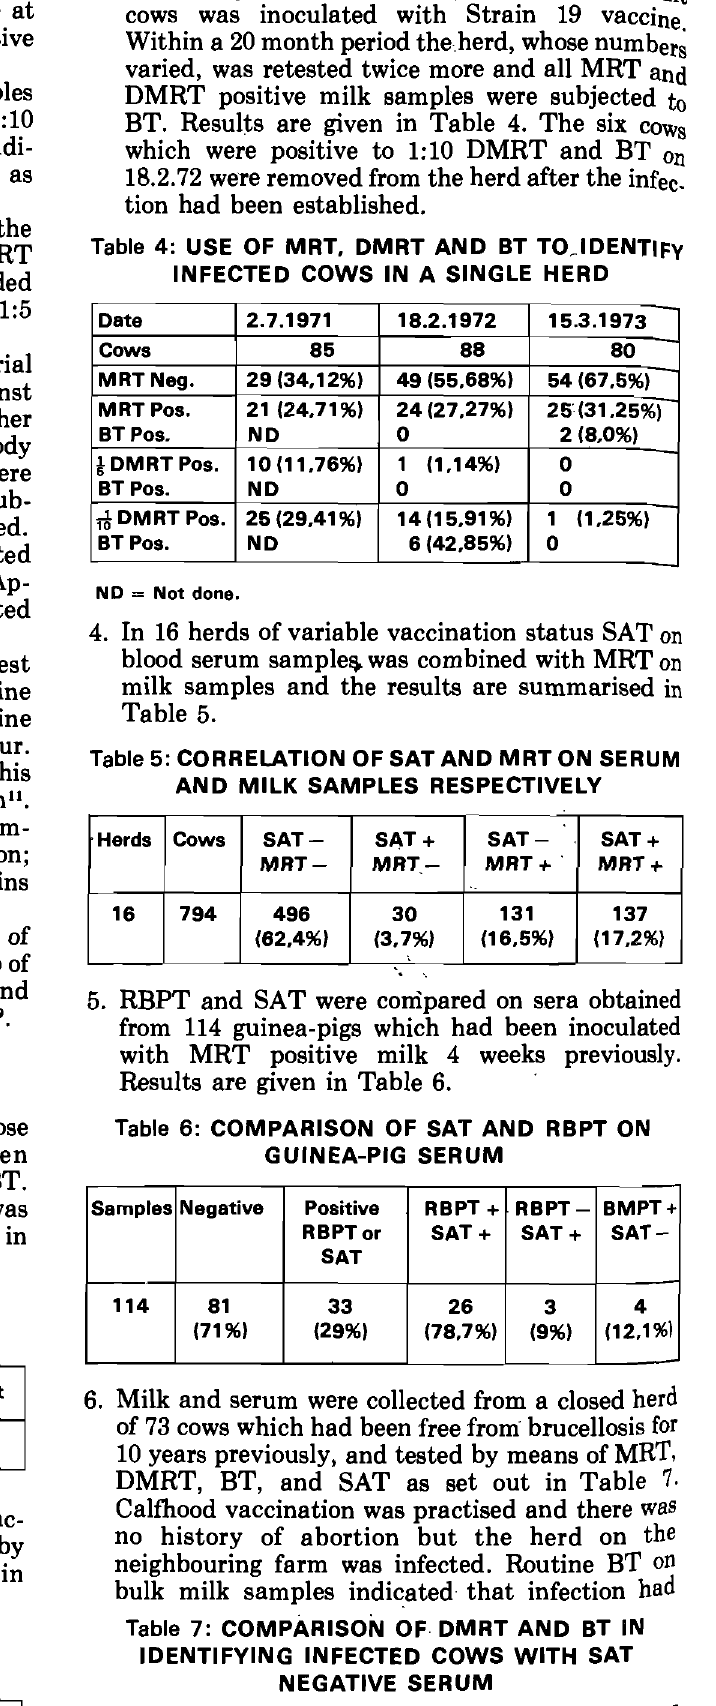
Table 7: COMPARISON OF DMRT AND BT